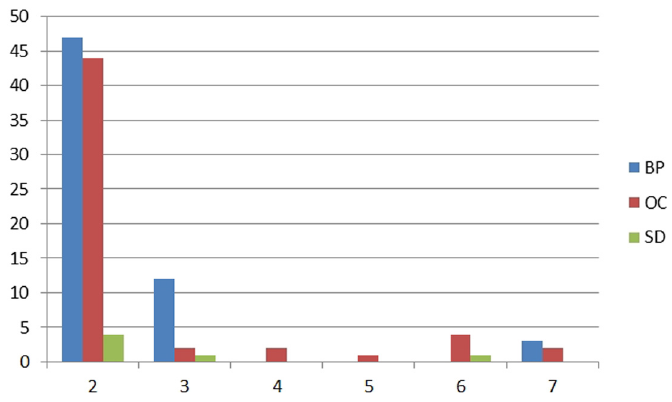
Figure 4: Racot 18. Bone fragmentation of cattle, sheep/goat, and pigs from loam pits, phase IIA ( x - axis represents comple - teness: 2 ≤ ¼ complete; 3 = ¼ – ½ complete; 4 = ½ – ¾ complete; 5 ≥ ¾ complete; 6 = almost complete; 7 = complete. BP, cattle; OC, domestic sheep and goats; SP, domestic pig ) ( after Marciniak, 2014a, Figure 9.3 ) .